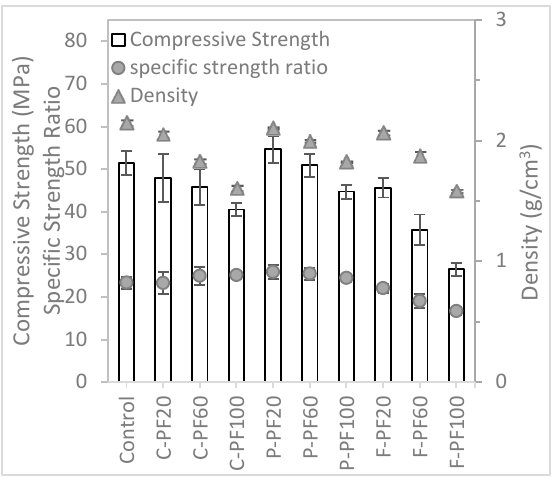
Figure 10. Compressive strength results of mixtures prepared with the packing factor method.